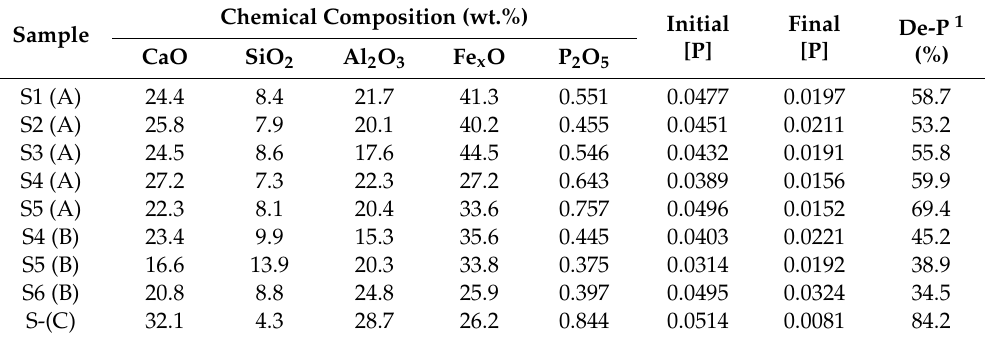
Table 3. The compositions of the slag; square brackets indicate the concentration in the metal. Chemical Composition Sample